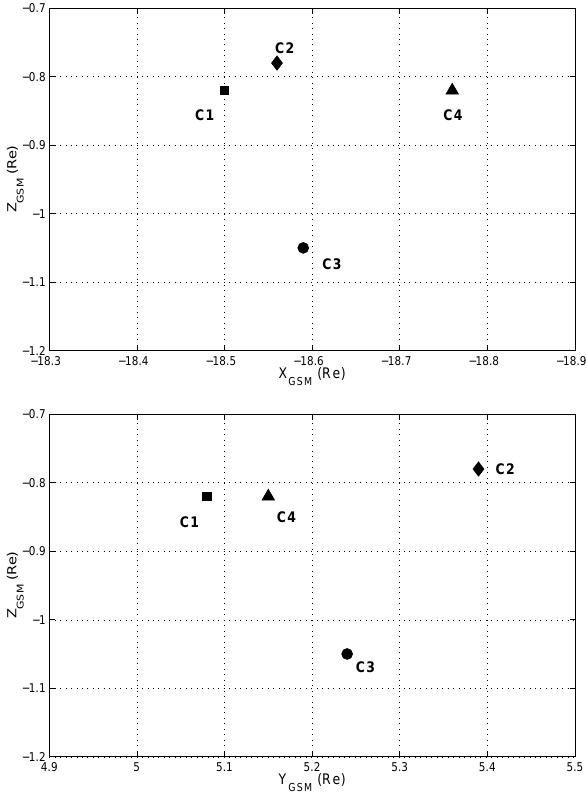
Fig. 3. The Cluster s/c relative locations at 20:39 UT.